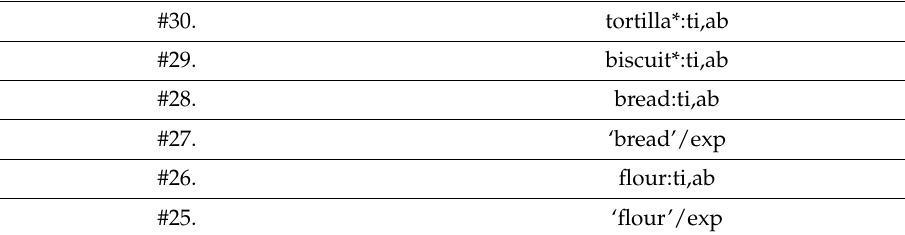
Figure S22: BMC Femoral Shaft (g); Figure S23: BMD Femoral Shaft (g/cm 2 ); Figure S24: Parathyroid hormone by calcium fortification level (pmol/L); Figure S25: Serum 1,25-dihydroxycholecalciferol by calcium fortification level (nmol/l); Figure S26: BMD Lumbar spine by calcium fortification level (g/cm 2 ); Figure S27: Weight by calcium fortification level (Kg); Figure S28: BMD Femoral neck by calcium fortification level (g/cm 2 ); Figure S29: BMD hip by calcium fortification level (g/cm 2 ); Figure S30: BMD total body by calcium fortification level (g/cm 2 ); Table S1: Number of studies, number of participants and result of the meta-analysis for primary and secondary outcomes.